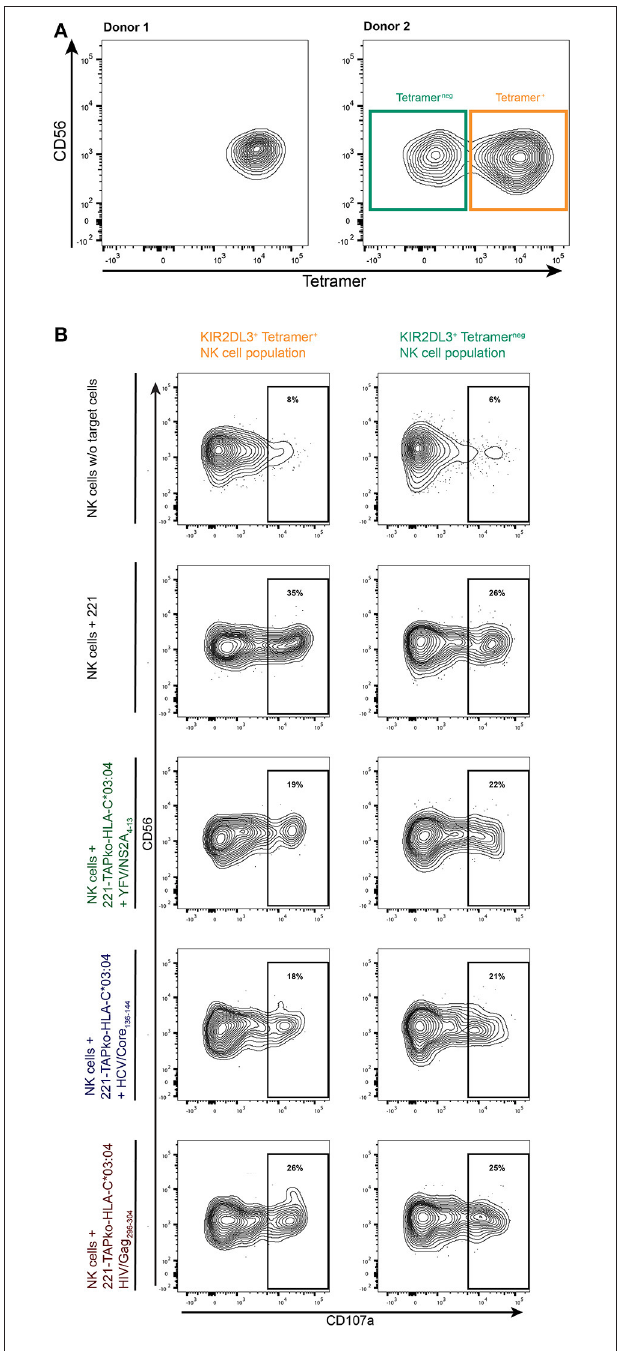
FIGURE 4 | Functional determination of tetramer + and tetramer neg KIR2DL3 + NK cell subpopulations. (A)